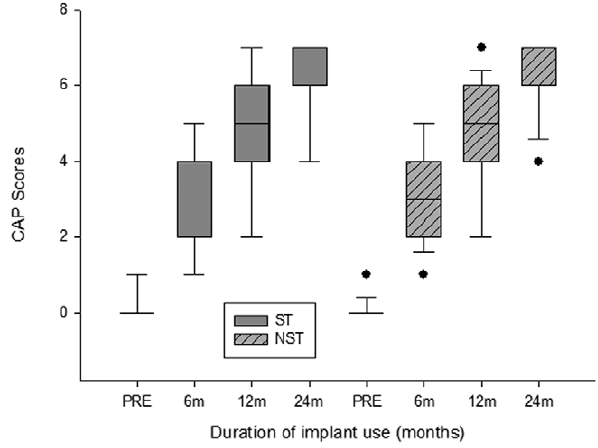
Figure 1. Box plot showing the distribution of CAP values of the two groups with the time of implant usage. Box plot explanation: upper horizontal line of box, 75th percentile; lower horizontal line of box, 25th percentile; horizontal bar within box, median; upper horizontal bar outside box, 90th percentile; lower horizontal bar outside box, 10th percentile. Circles represent outliers.